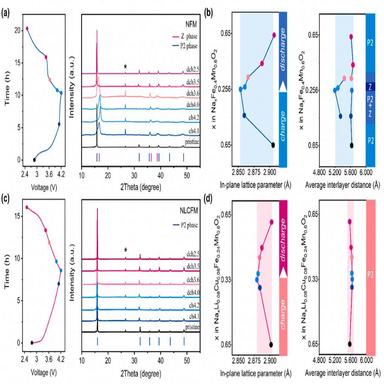
Ex-situ XRD characterization on the structural evolution of NFM and NLCFM electrodes. (a, c) The ex-situ XRD patterns were collected during the first cycle under a current rate of 0.1 C for NFM and NLCFM electrodes, with the corresponding first cycle electrochemical curves on the left. \ represents the peaks from Al foil. (b, d) The evolution of in-plane lattice parameter, average interlayer distance fitted by ex-situ XRD patterns.